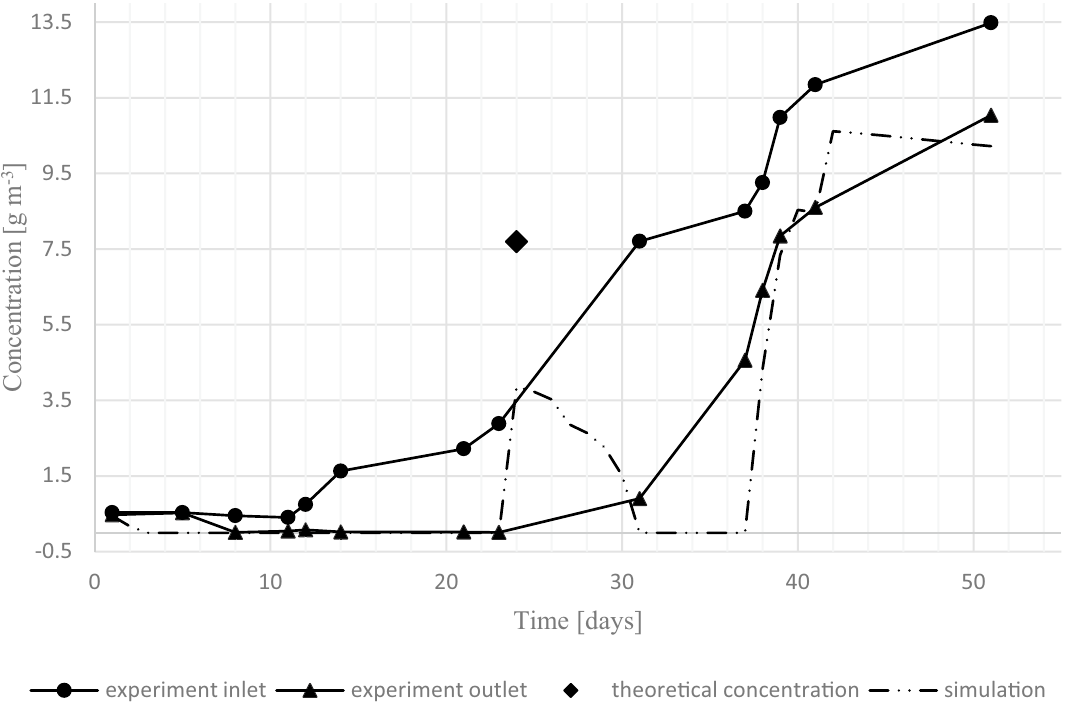
Figure 2. Experimental results and model prediction of toluene biofiltratin (EBRT = 4.5 min). The single data point depicted as a rhomboid, represents the theoretical increase in the biofilter inlet after increasing the inlet concentration—the actual measurement at the inlet was carried out a later day.